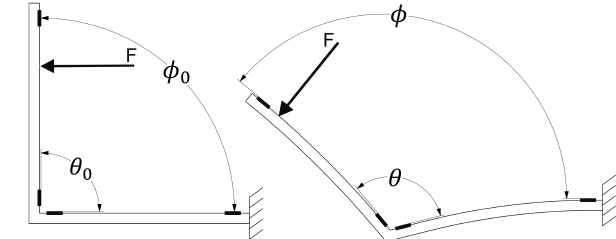
Figure 2. The image on the left represents the initial or unstrained state of the sample as viewed from above, and the right is an outward deflection of the sample. θ and φ are used to calculate the hinge